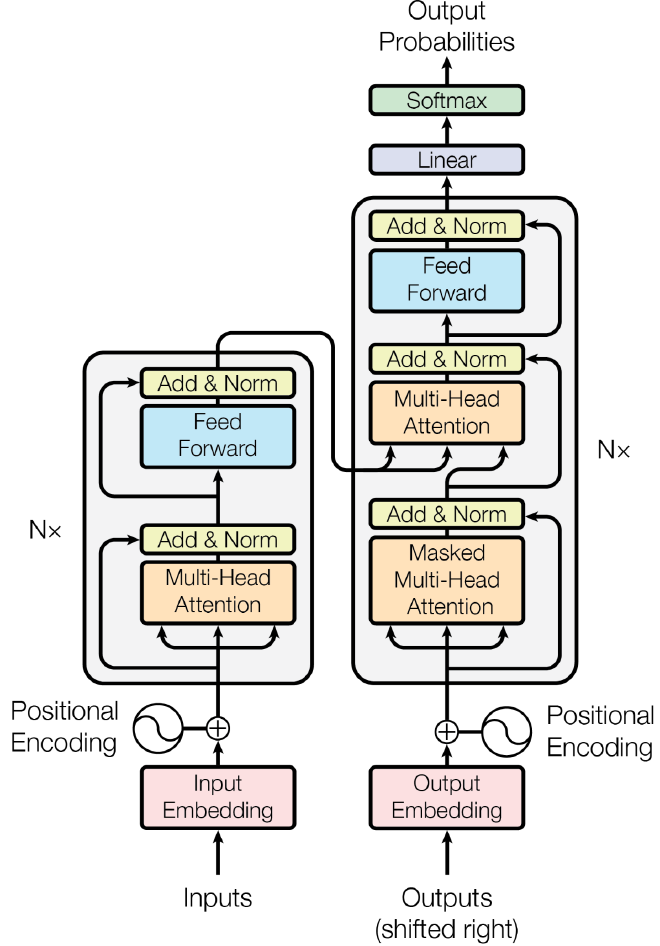
Figure 3. The transformer model architecture